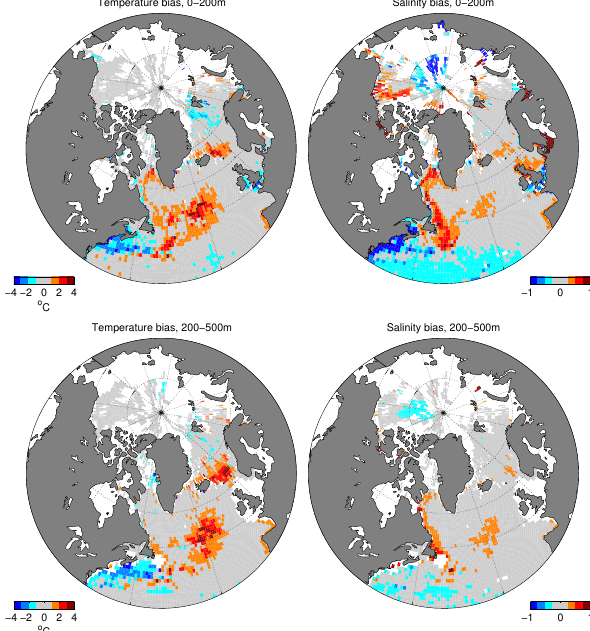
Figure 5. Mean current speed at 15m depth (top) from a drifter cli- matology and (bottom) from hindcast H05 averaged for the period 2003–2009. The model output has been regridded to the same 1/2 ◦ resolution as the drifter climatology.